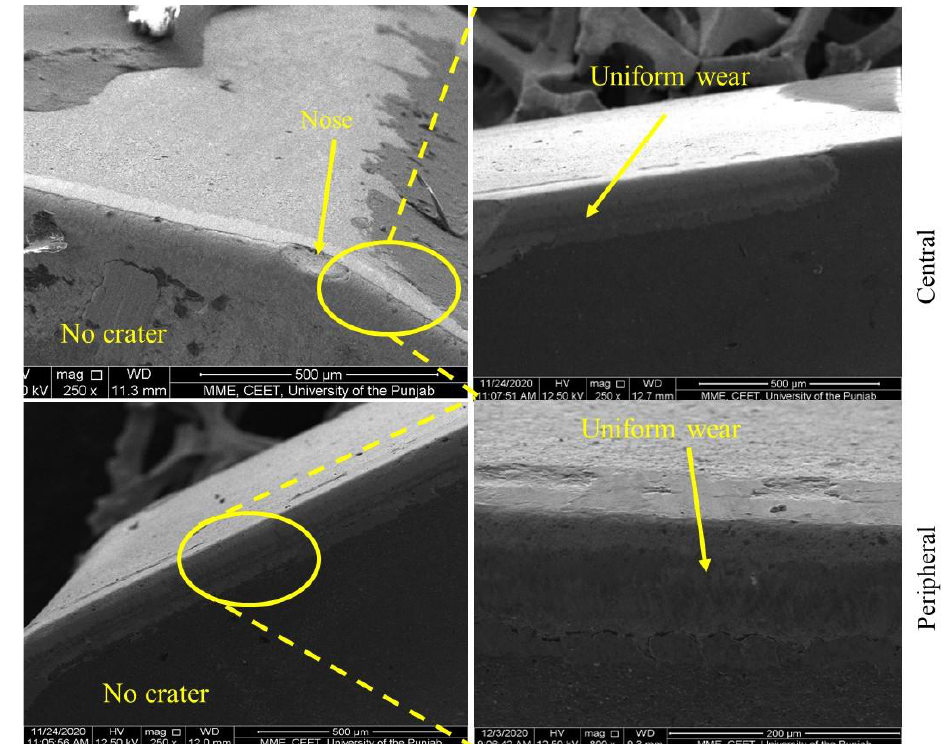
Figure 17. Wiper and central insert tool wear progression experiment 9.